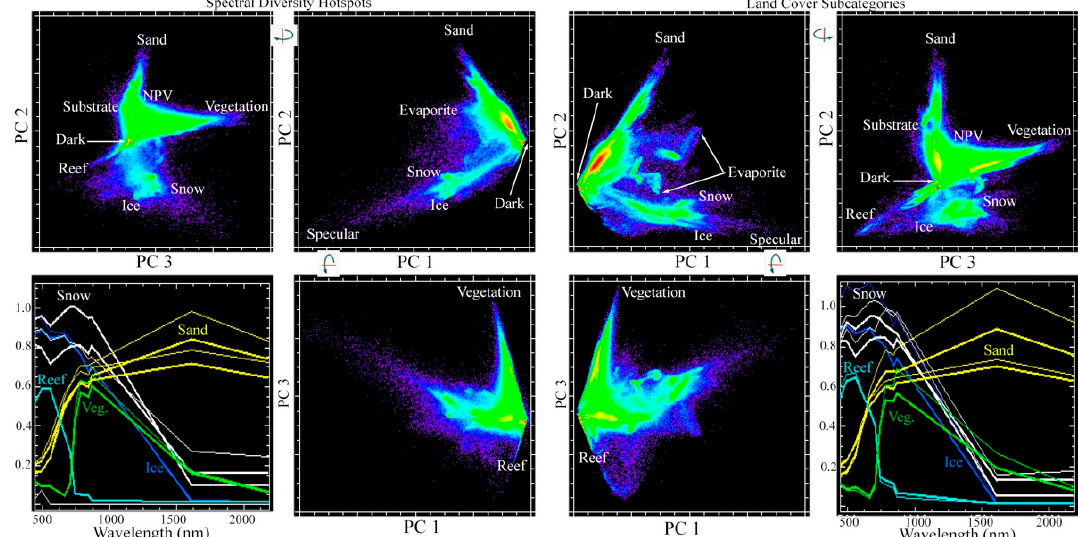
Figure 4. Spectral mixing spaces for Sentinel 2 mosaics. Orthogonal projections show the 3D topology of the PC spaces as continuous with clearly defined apexes corresponding to physically distinct spectral endmembers. Vegetation and Sand + Substrate endmembers show strongly linear mixing with the Dark (shadow or water) endmember. Both mosaics have very similar topology and endmembers in the 3D PC space, indicating that the 120 land cover subcategories capture the salient features of the 110 spectral diversity hotspots.